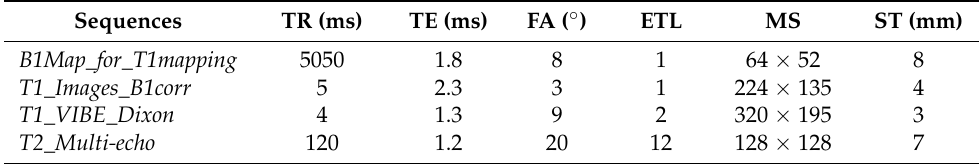
Table 2. Sequence data for the assessment of fibrosis, steatosis and hepatic iron overload at 3T. Sequences TR (ms) TE (ms) FA ( ◦ ) ETL MS ST